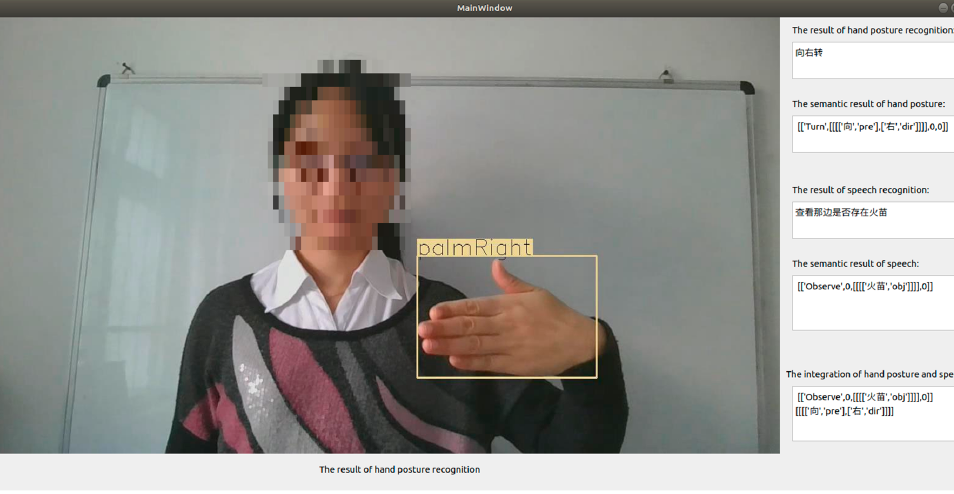
Figure 26. Results of the integration of deictic hand posture and spoken instructions.